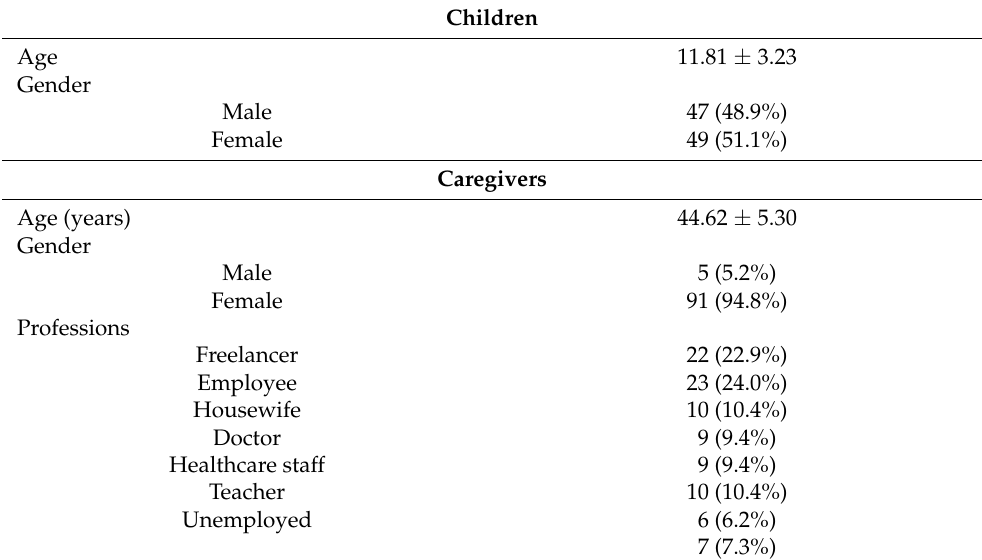
Table 1. Descriptive analysis of children’s and caregivers’